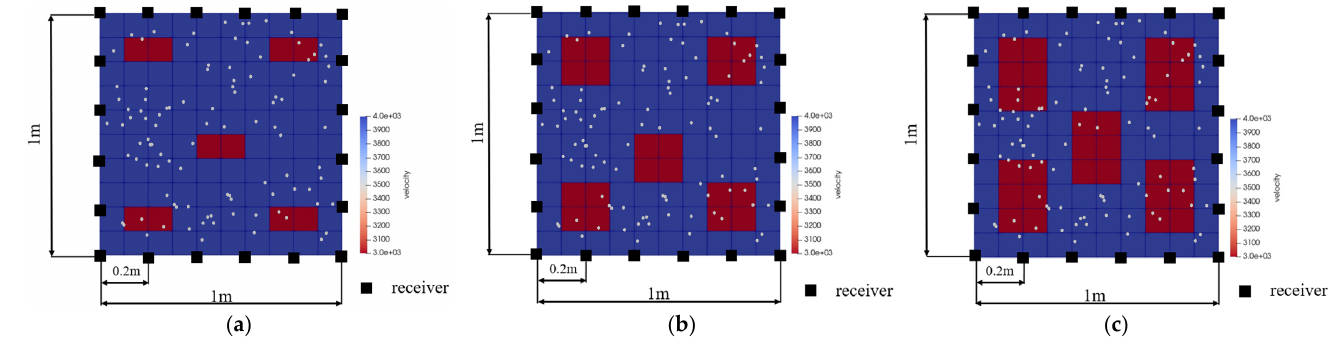
Figure 3. Different rates of the damaged area in the original distribution: ( a ) damage area with 10 cells (10%); ( b ) damage area with 20 cells (20%); ( c ) damage area with 30 cells (30%).